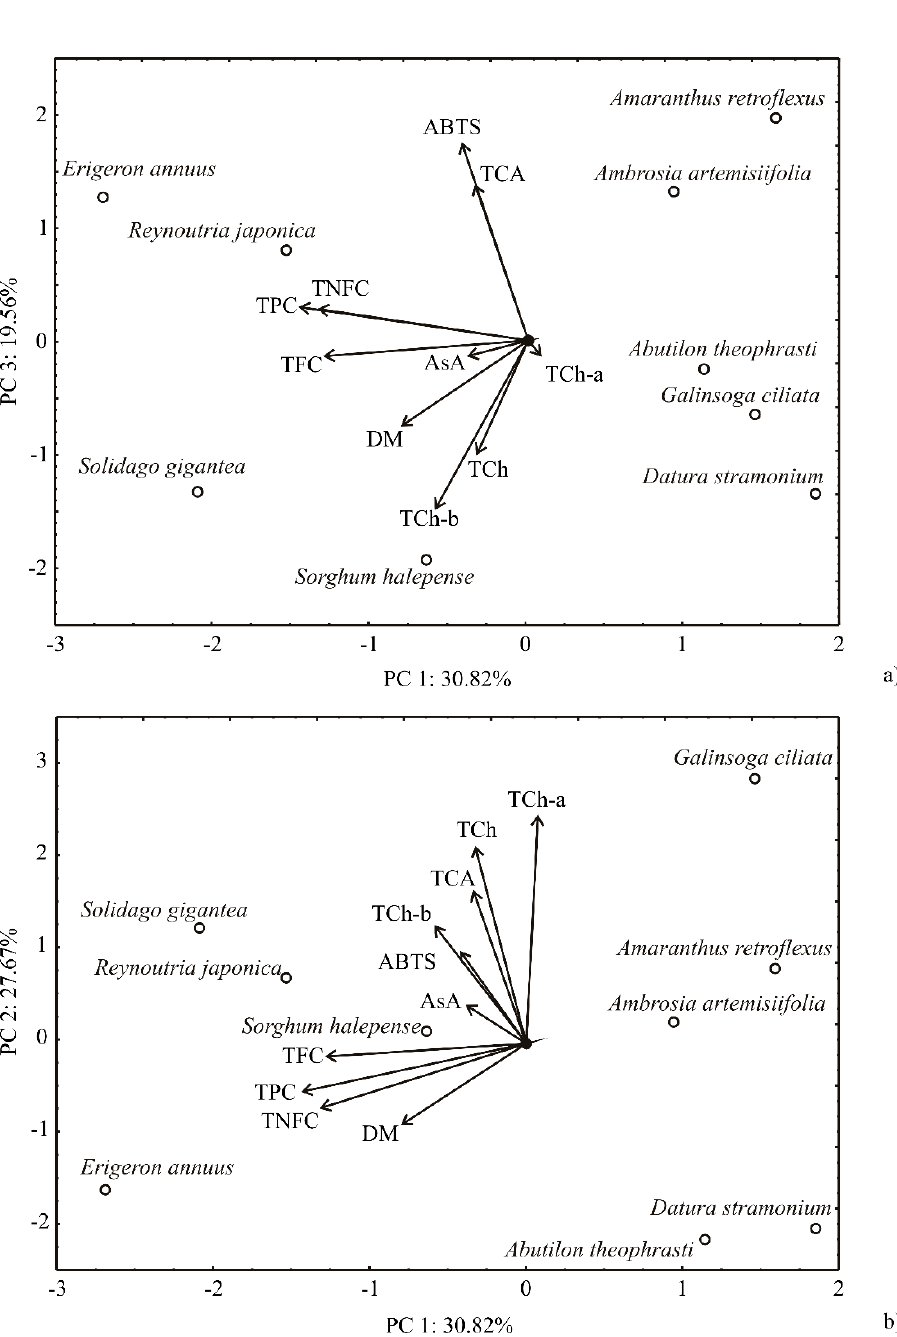
Figure 5. PCA ordination of variables based on component correlations: ( a ) projection in PC1–PC3 factor plane; ( b ) projection in PC1–PC2 factor plane. DM—dry matter; TPC- total phenol content; TNFC—total nonflavonoid content; TFC—total flavonoid content; TCh—total chlorophyll content;